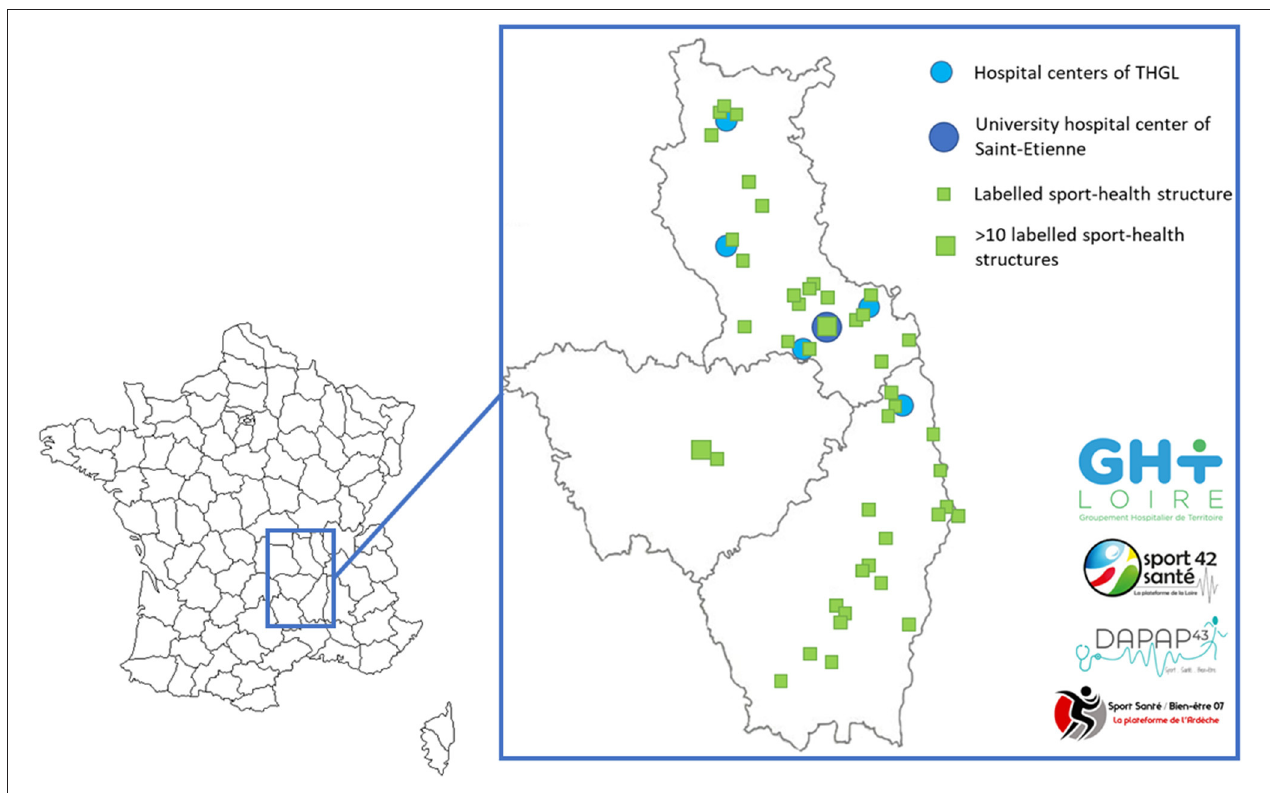
FIGURE 1 | Project collaborators mapping. THGL: Territorial Hospital Group of Loire.